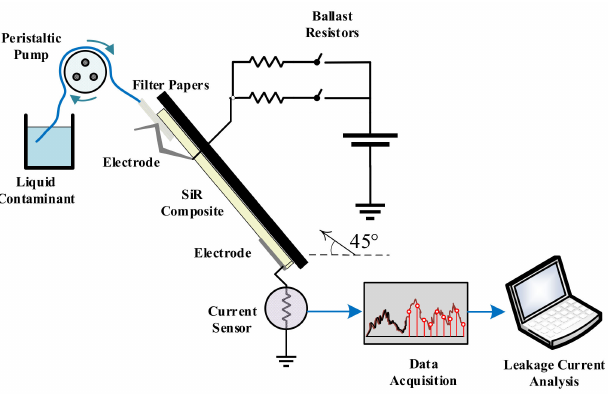
Figure 1. +DC inclined plane-tracking and erosion test (IPT) setup with the leakage current acquisi- tion system.